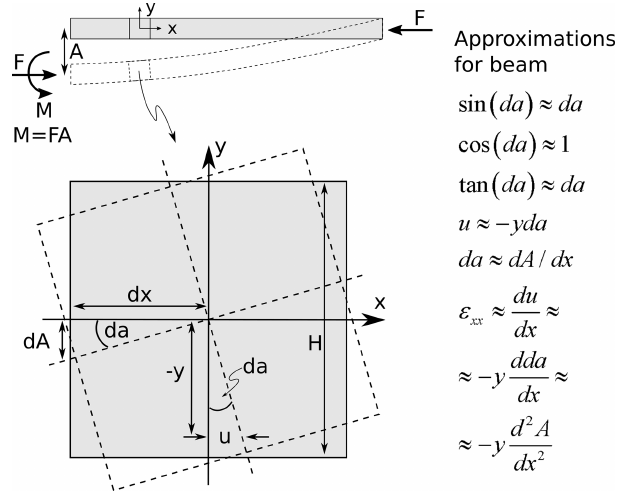
Figure 9. Sketch illustrating the Euler–Bernoulli beam theory and the related thin-plate